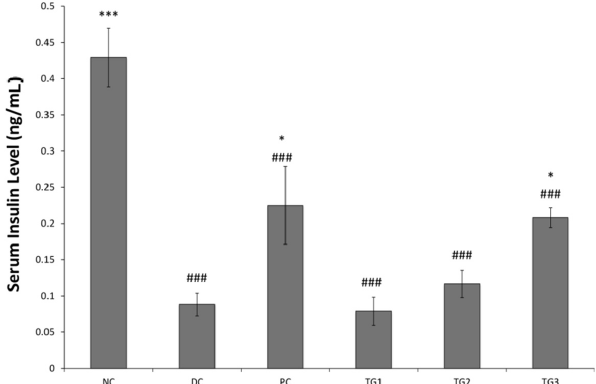
Figure 6. Serum Insulin Levels after 14 days of treatment with Gongronema latifolium extract. Values are expressed as the mean ± SEM, * = p < 0.05; *** = p < 0.001 vs. DC; ### = p < 0.001 vs. NC.